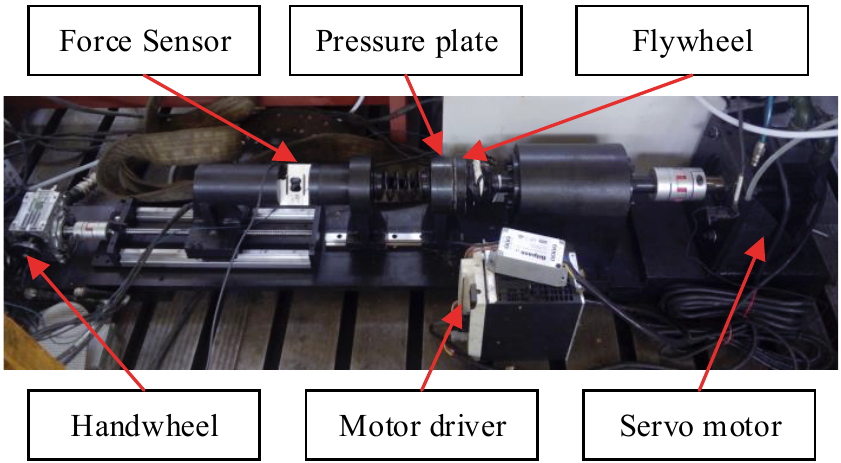
Figure 5. Temperature measurement test rig.